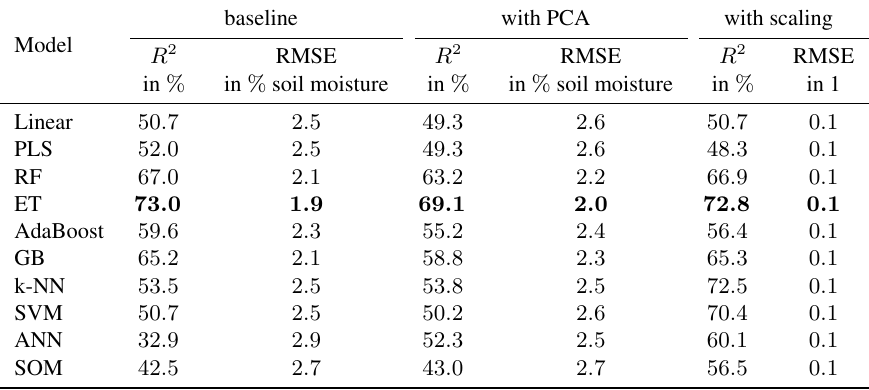
Table 1. Regression results for the soil-moisture estimation.